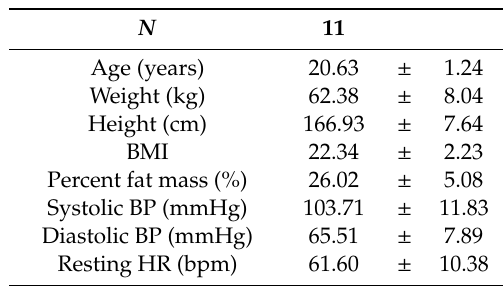
Table 2. Subject characteristics a .